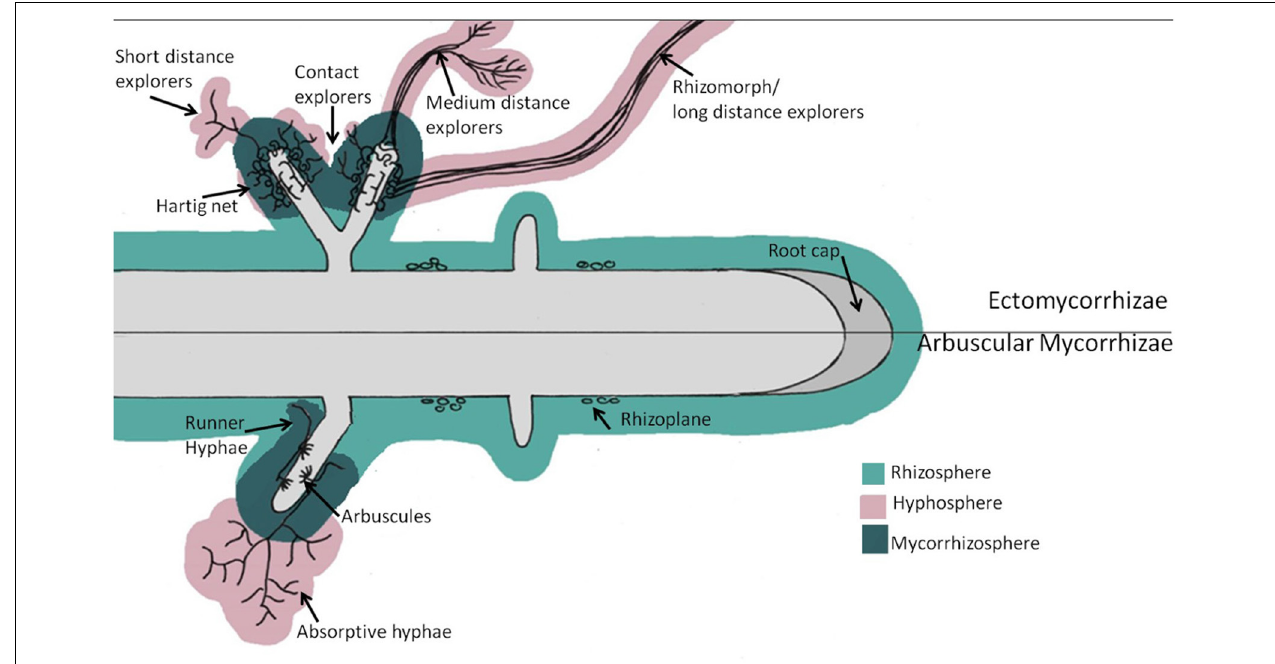
FIGURE 1 | Schematic view of root-mycorrhizal zones of influence and the various mycorrhizal growth forms. Rhizoplane describes the area adjacent to the root where the soil particles adhere. The Rhizosphere is the area of soil around the root that is influenced by root-exuded labile C. The